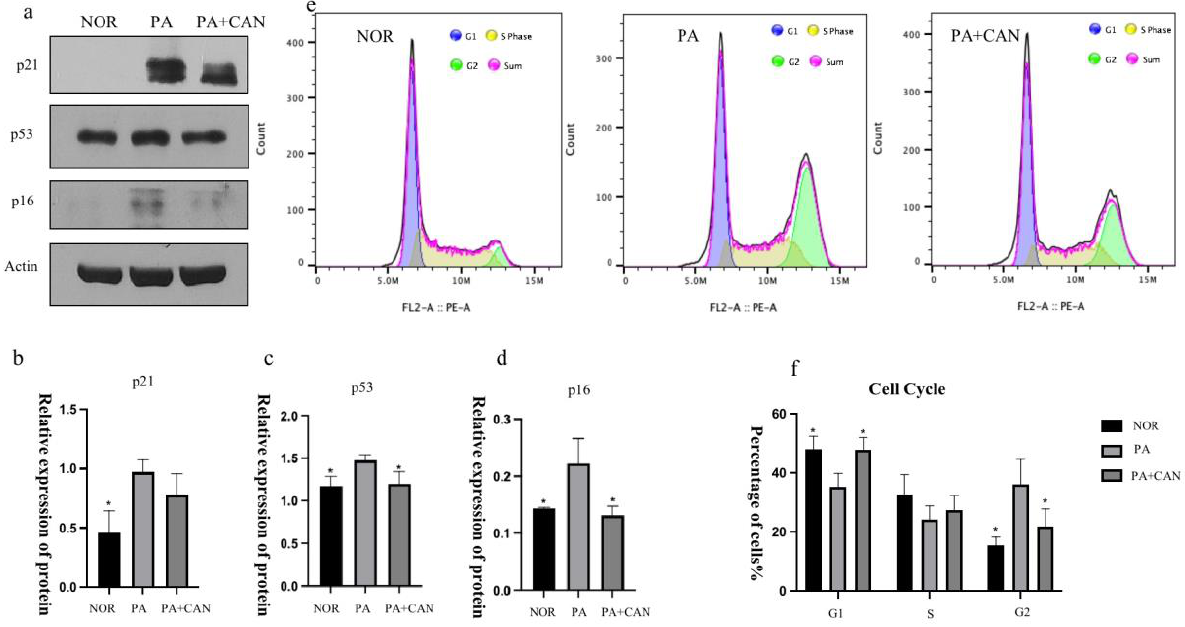
Figure 5. CAN regulated the cell cycle of senescent HUVECs. ( a – d ) CAN (5 µ g/mL) reduced PA-induced elevation of cell cycle regulators p21, p53 and p16. ( e , f ) CAN (5 µ g/mL) ameliorated PA- induced cell cycle arrest in HUVECs. Data are expressed as the means ± SD ( n = 3); * p < 0.05 vs. PA. 3.5. CAN Alleviates PA-Induced HUVEC Replicative Senescence by Inhibiting p38 Activation The p38MAPK pathway is a key regulator of the biosynthesis of pro-inflammatory cytokines that may contribute to chronic low-grade inflammation during aging, and the ele- vated protein levels of the phosphorylated active form of p38MAPK (phospho-p38 MAPK)